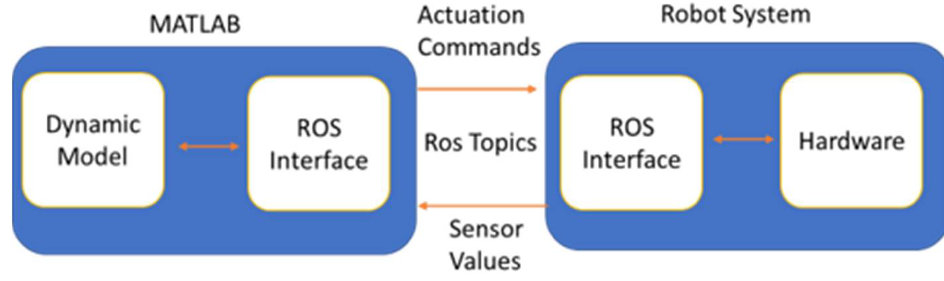
Figure 19. MATLAB–ROS communication diagram.